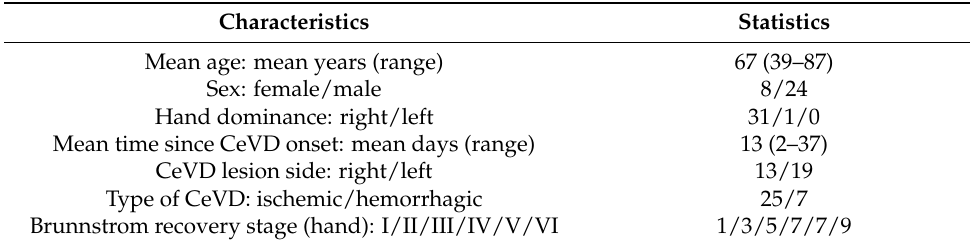
Table 1. Participants’ baseline